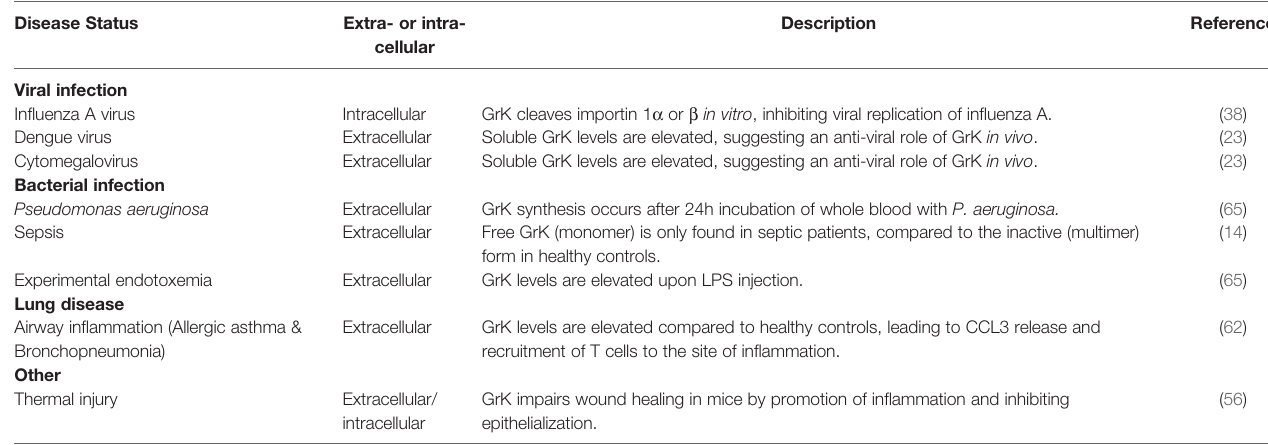
TABLE 2 | Intracellular and extracellular GrK in human